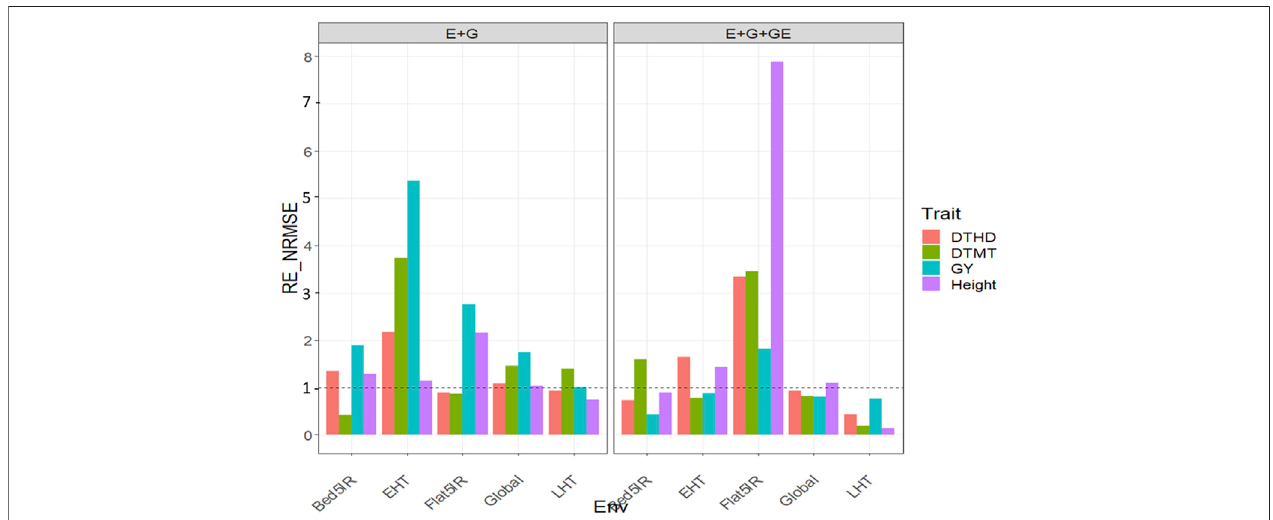
FIGURE 1 | Relative ef fi ciency in terms of normalized root mean square error (RE_NRMSE) computed by dividing the NRMSE under the best linear unbiased predictor model (GBLUP) between the NRMSE of the partial least squares regression method. Prediction performance is reported for each environment and across environments (Global) in dataset 1 (EYT_1), also with two predictors (E + G and E + G + GE). When the RE_NRMSE > 1 the PLS outperforms in terms of prediction performance (lower NRMSE) the GBLUP method.